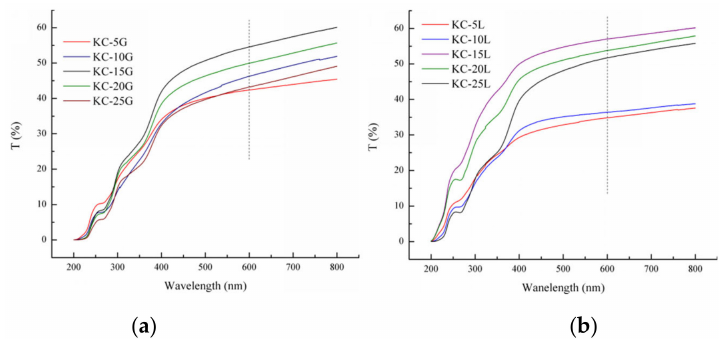
Figure 4. Light transmittance of the composite film containing GG ( a ) and LG ( b